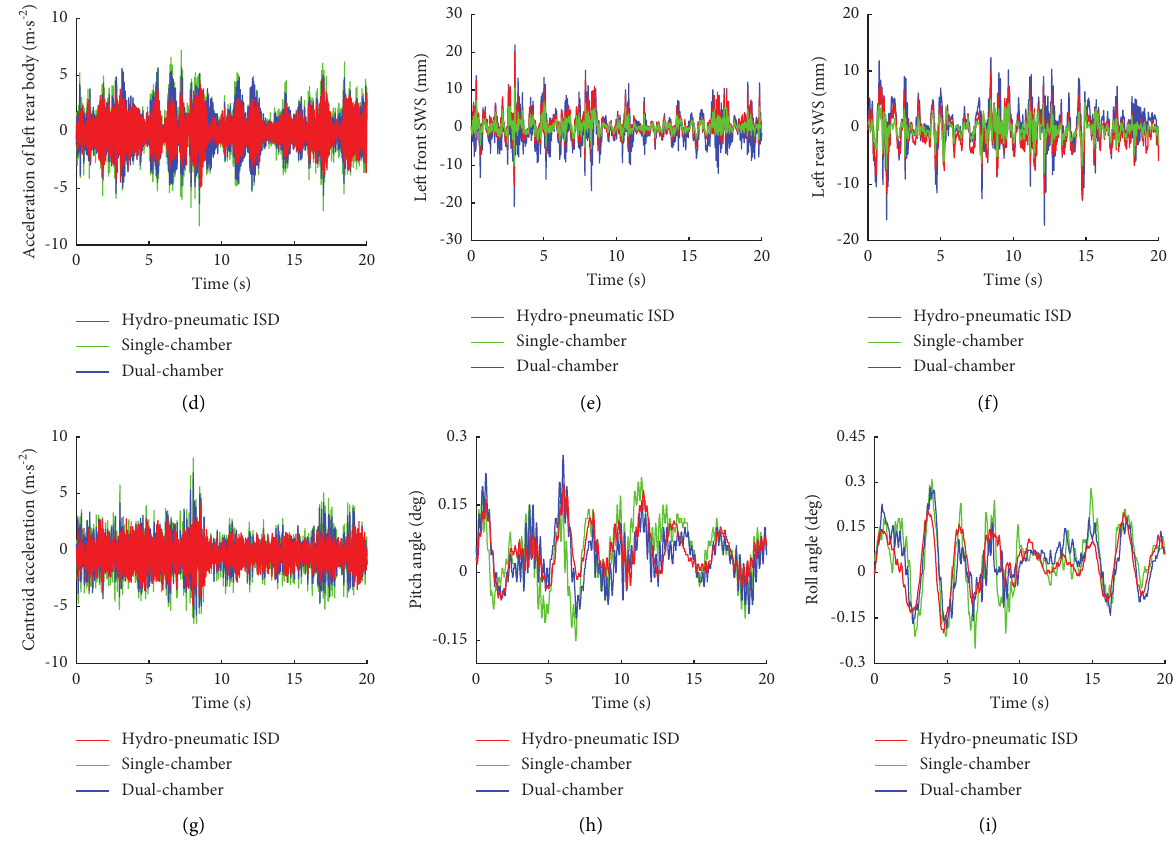
Figure 13: Comparison of random input test